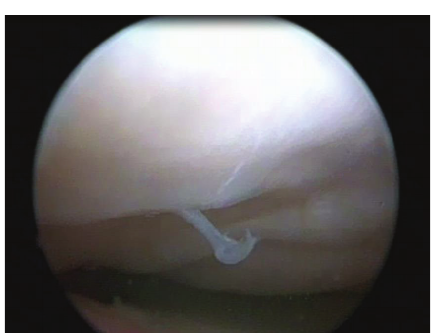
Figure 6: Arthroscopic view of the intercondylar notch of the left knee. The tibial spines covered by synovium tissue were deformed like a “ball-and-socket”